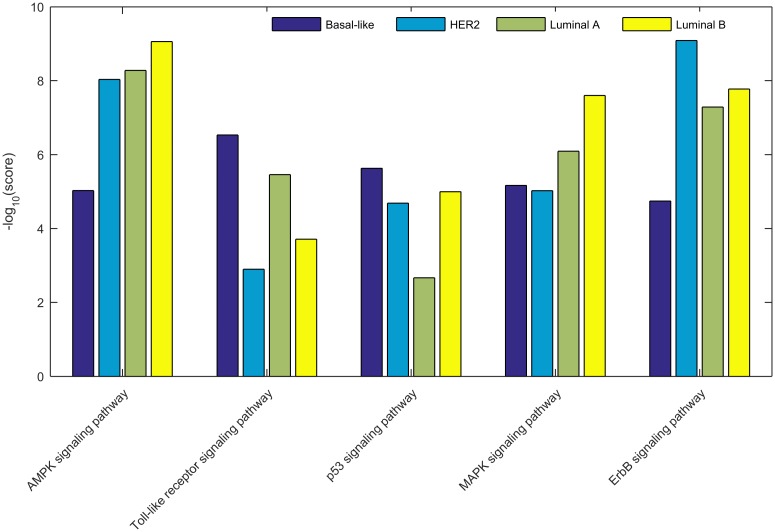
Pathway scores compared across breast cancer subtypes for a selection of pathways.Dark blue = Basal-like, light blue = HER2, green = Luminal A and yellow = Luminal B.